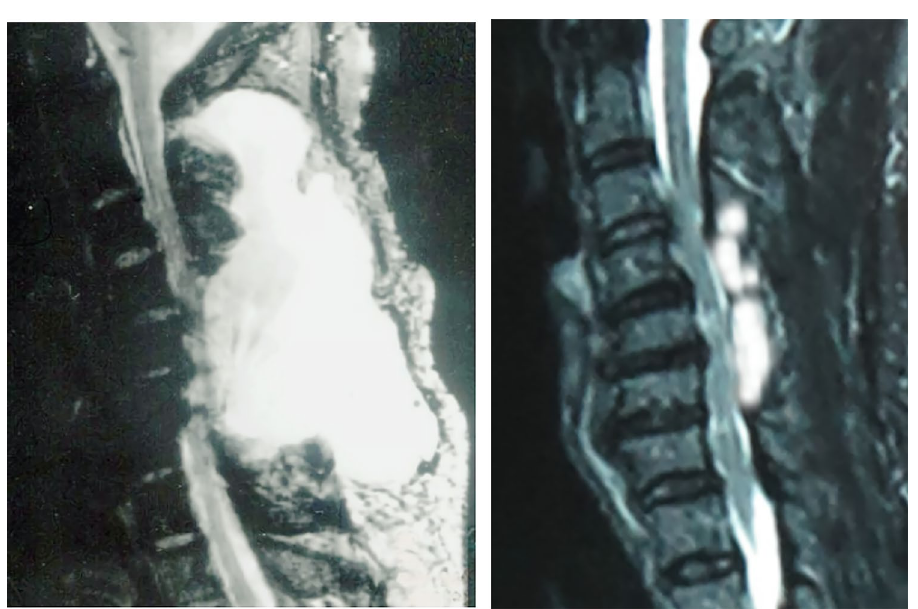
Figure 2. The second case. ( a ) Pre-operative area of the pseudomeningocele on sagittal MRI section. ( b ) Post- operative area of the pseudomeningocele on sagittal MRI